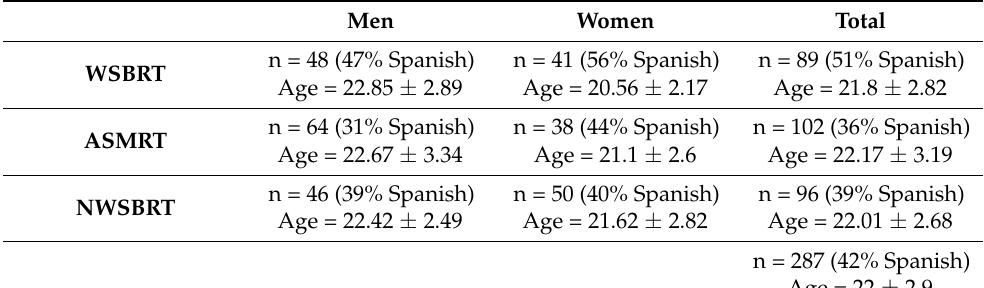
Table 1. Distribution of the sample according to the spatial memory test